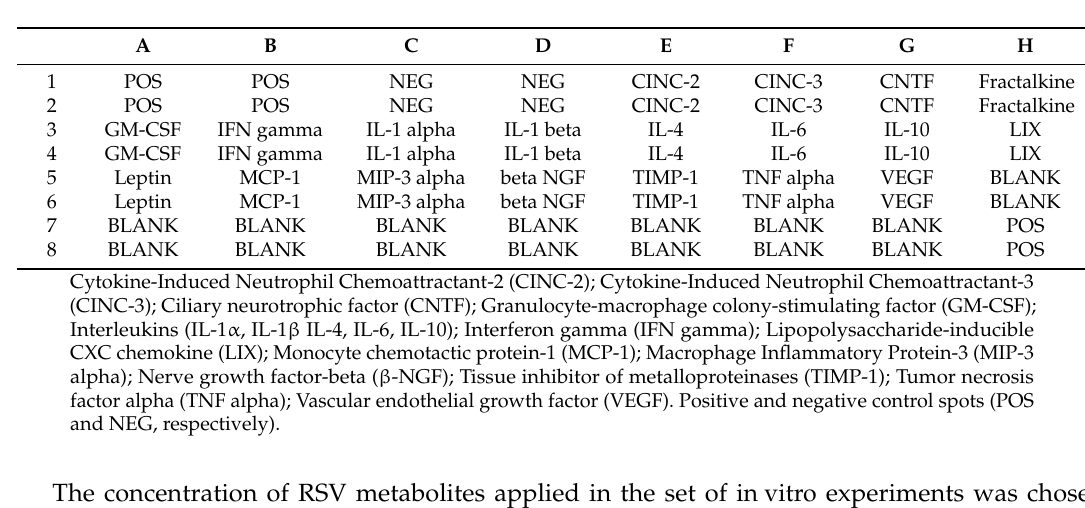
Table 1. Cytokine and growth factor antibody